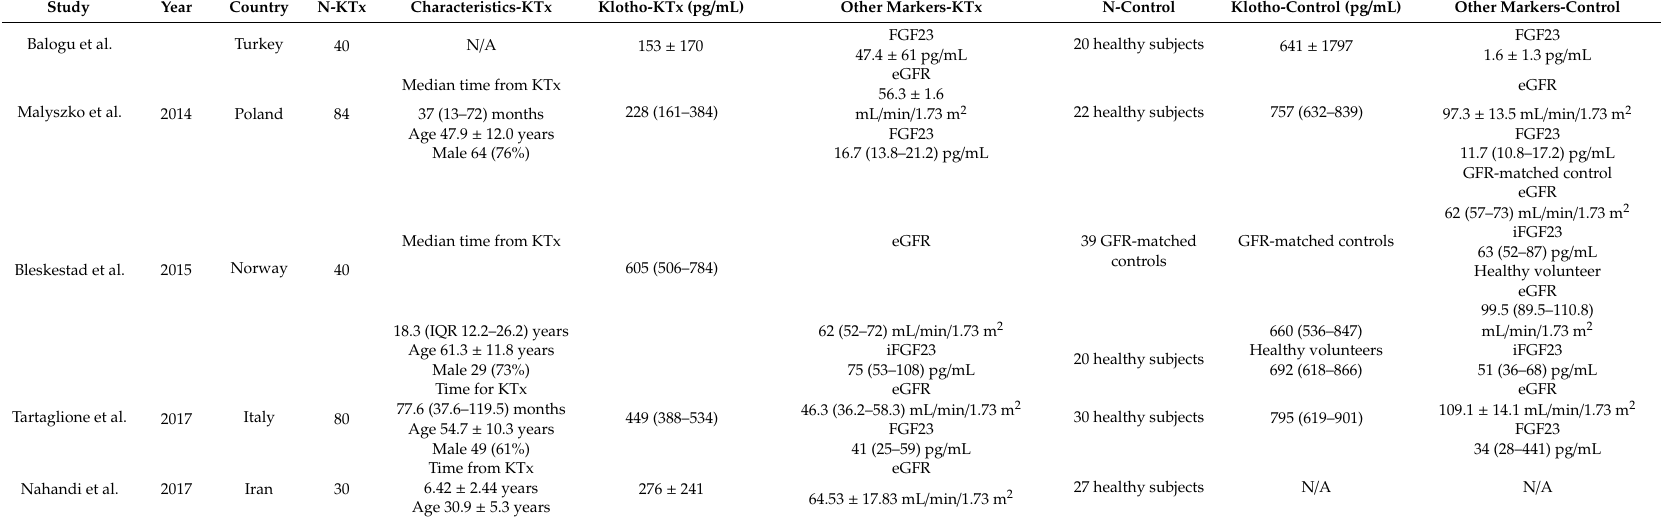
Table 2. Characteristics of the included studies comparing serum klotho between KTx recipients and healthy